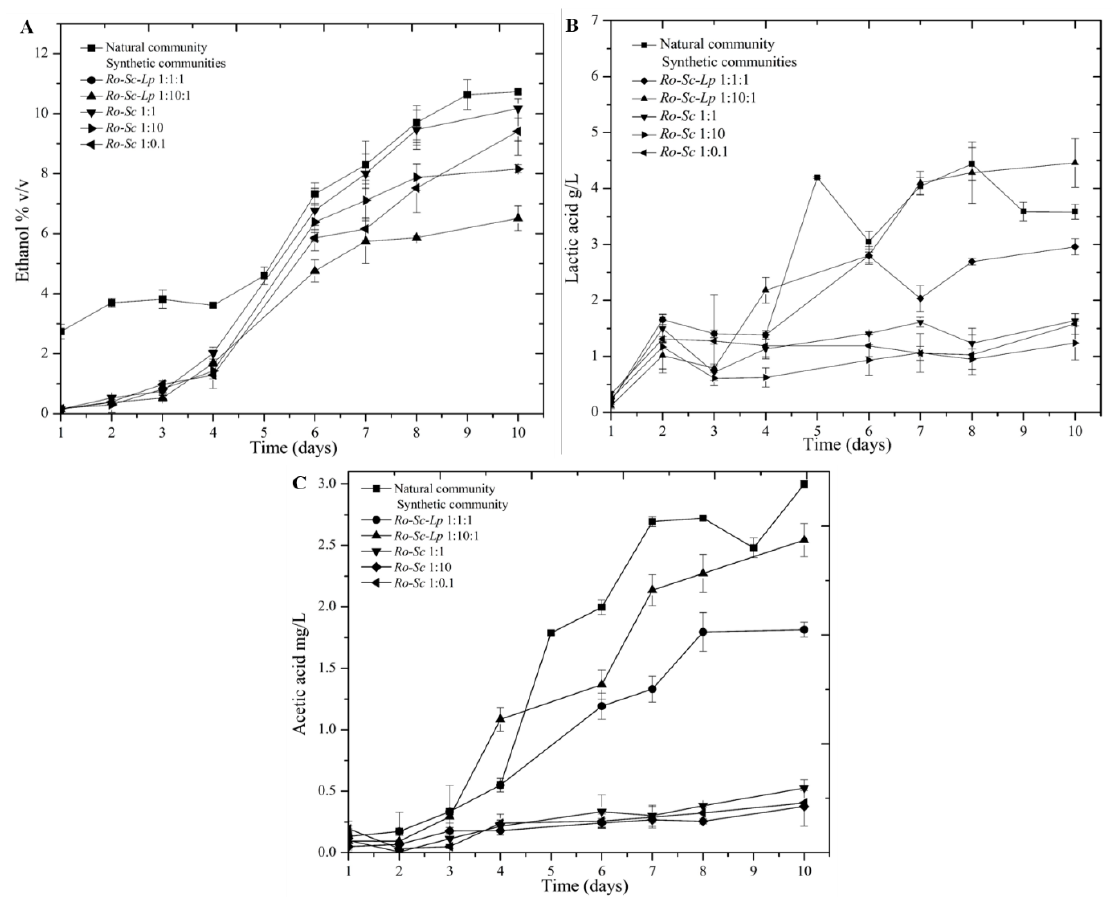
Figure 1. Kinetics of ethanol ( A ), lactic acid ( B ) , and acetic acid ( C ) during fermentation by natural and synthetic communities. Synthetic communities were prepared with different ratios of microbial species. In all cases, Rhizopus oryzae was inoculated at an initial concentration of 10 6 spores/ml. For the cultures involving either S. cerevisiae or L. plantarum , their initial concentrations are indicated by 0.1, 1, or 10, corresponding to 10 5 , 10 6 , and 10 7 CFU/mL, respectively. Table 1. Final concentration of ethanol and organic acids at day 10, the end of the traditional rice wine brewing process.